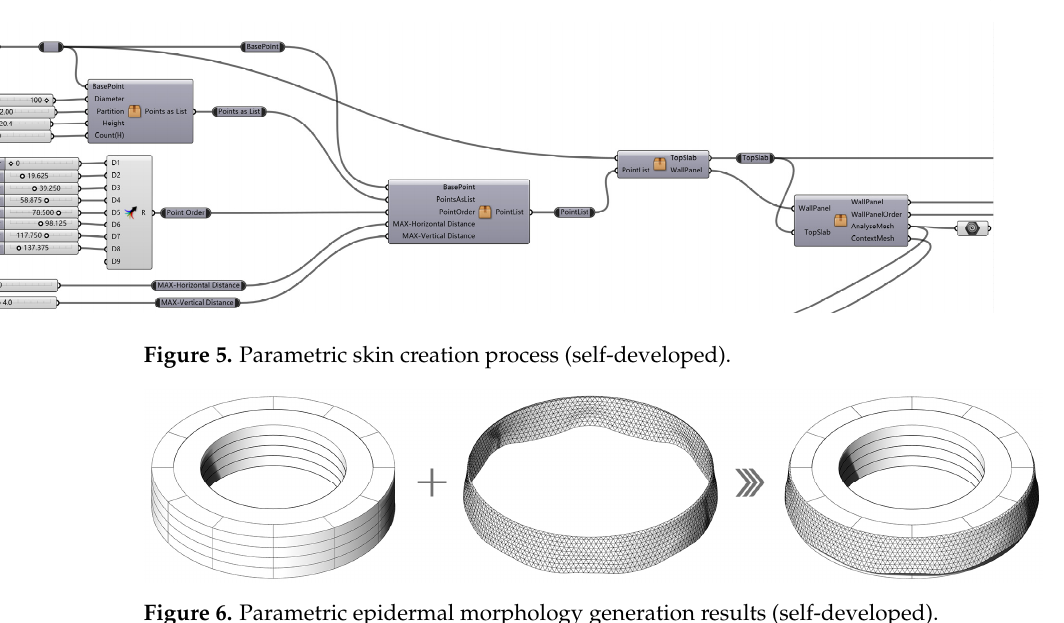
Figure 7. Structure of the epidermal unit of the triangle (self-developed). Dynamic building skins typically have a certain control cycle, responding primarily to seasonal changes, date changes, diurnal changes, and real-time control. To simplify this study and consider the effectiveness and difficulty of controlling the skin, this study considers a 24-h control period for the skin unit, i.e., an optimization control according to the date of the change. 3.3. Performing Photothermal Simulations of Building Skins By importing the building skin model into the Ladybug Tools platform, we ob- tained the simulated data on sunlight hours and sunlight radiation for a specific date, as presented in Figure 8. The above simulation method was used to simulate the building’s photothermal data for two official Ladybug Tools sample files [46]; the simulation results of sunlight